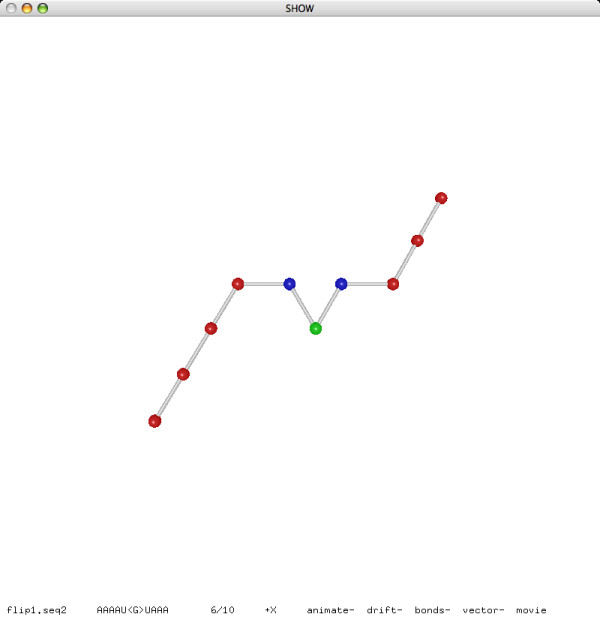
A flip move (after).